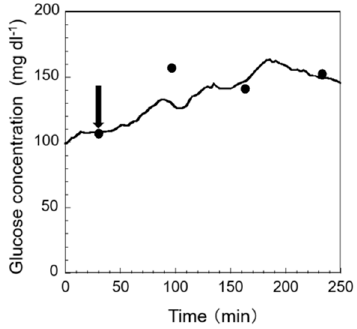
Figure 7. Monitoring stress response to ammonia addition. Glucose concentrations in the blood, plotted as the first black circles, were used for the one-point calibration method. All other black circles indicate the blood glucose concentration that is described in Section 2.6.2. The arrow marks the time at which the ammonia concentration changed from 0.25 mg L − 1 to 10 mg L − 1 .